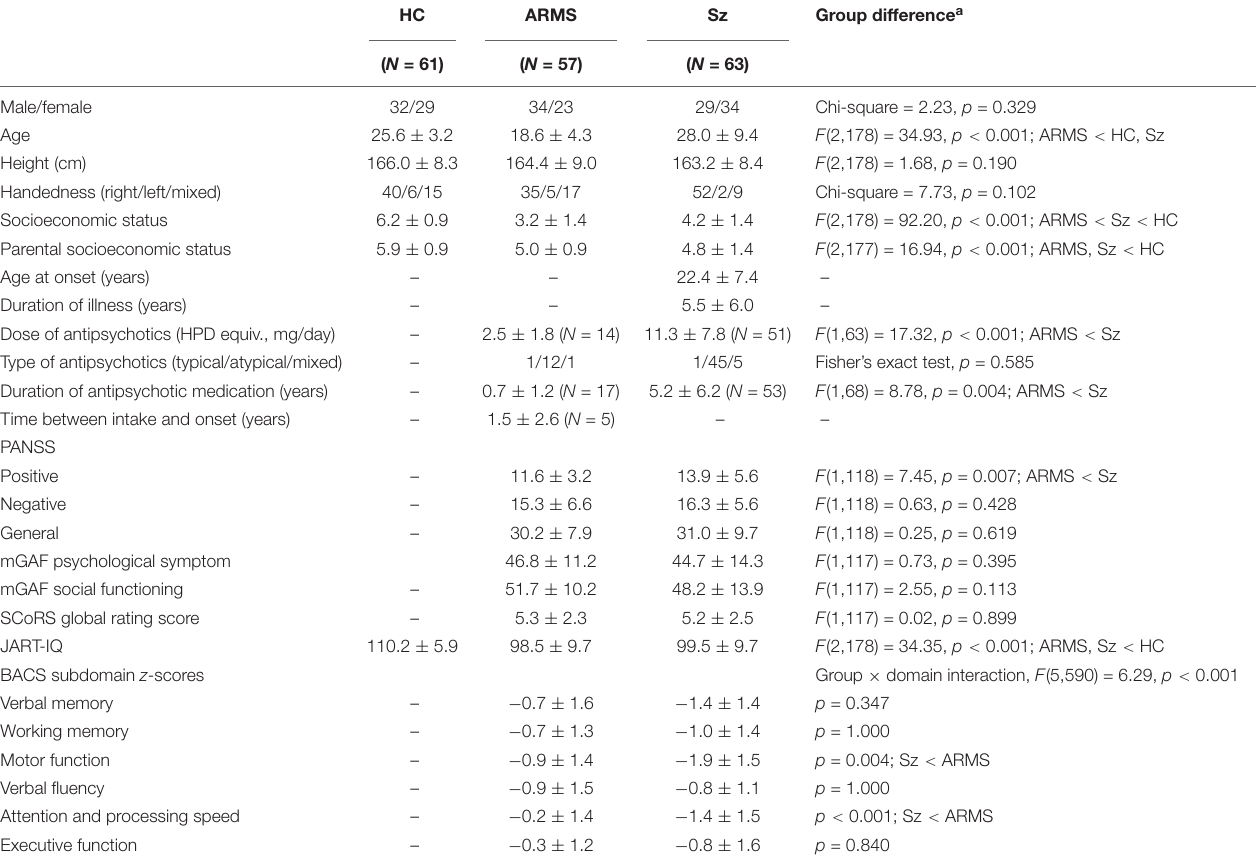
TABLE 1 | Demographic/clinical characteristics and sociocognitive functions in ARMS, schizophrenia, and control subjects. HC